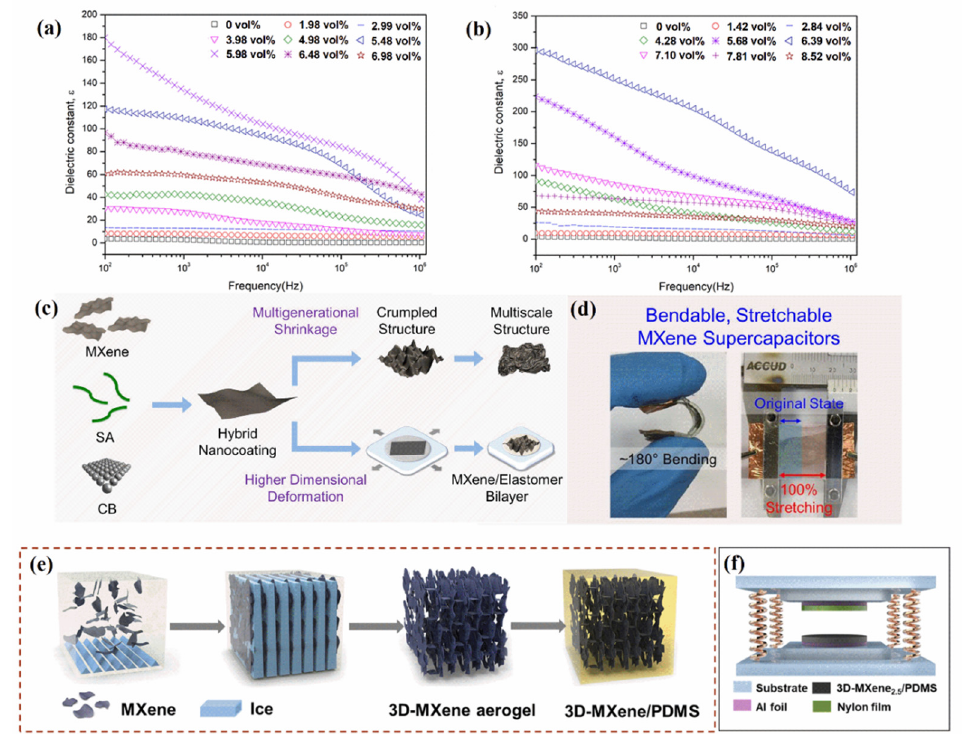
Figure 8. Dielectric constant of ( a ) Ti 3 C 2 T x /AE and ( b ) PANI-Ti 3 C 2 T x /AE (Reprinted with permission from Ref. [76]. Copyright 2021, copyright Elsevier). ( c ) Schematic of fabrication of high-areal-capac-